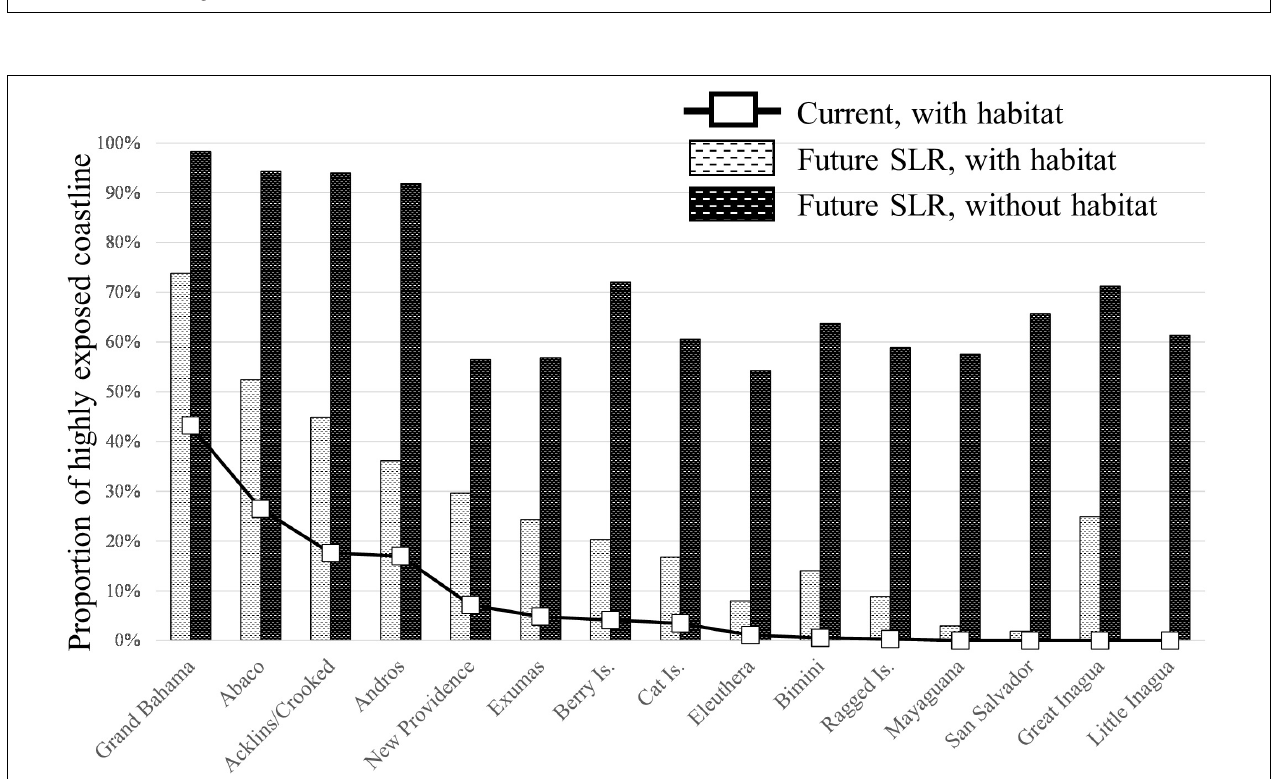
FIGURE 5 | Percentage of highly exposed coastline for each major island in The Bahamas, with and without coastal and marine ecosystems, currently and with future SLR.